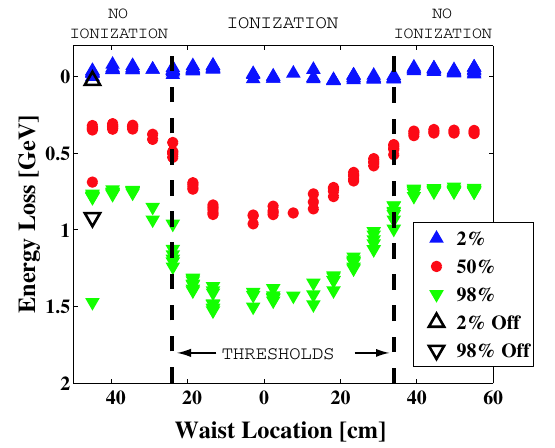
FIG. 4. (Color) ( Li (cid:1) (cid:1) (cid:3) ) Distribution of the 2%, 50%, and r 98% charge levels as a function of the beam’s waist location. The 4 and 5 represent the 2% and 98% charge levels of the beam with no plasma. For illustration, the ionization threshold is noted by the dashed